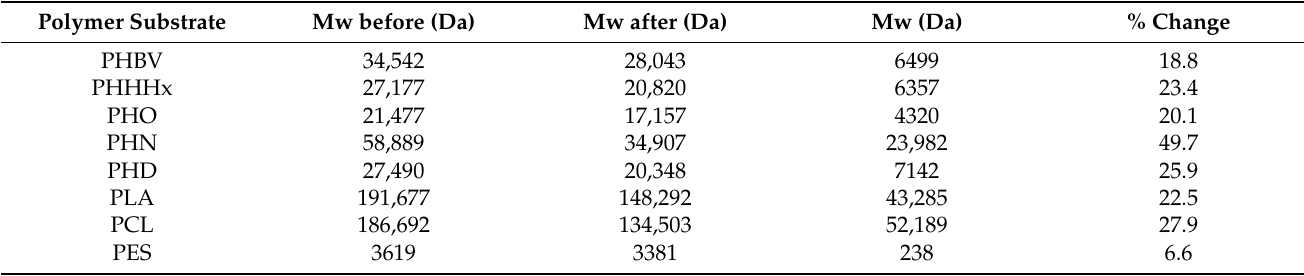
Table 4. Percent decrease in polymer molecular weight after treatment with LIP3.